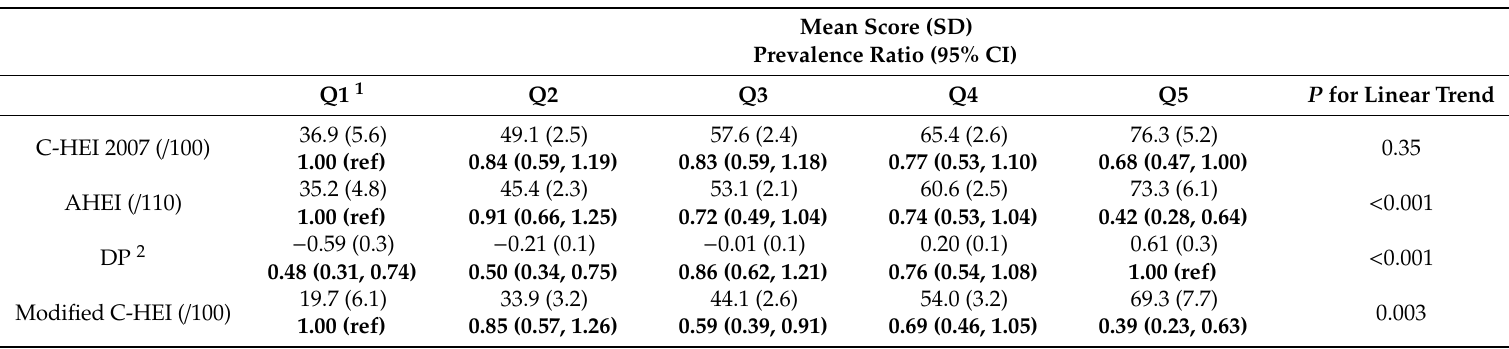
Binomial regression adjusted for age (continuous), physical activity (continuous), energy (continuous), smoking status (2 categories), sex (2 categories), ethnicity (2 categories), marital status (2 categories), and education (3 categories). Note: P for linear trend across the prevalence ratio for all quintiles. 1 Reference is the 5th quintile (strongest adherence and lowest diet quality) for DP and the first quintile (lowest adherence and lowest diet quality) for C-HEI 2007, AHEI, and Modified C-HEI. 2 Scores for the DP were generated by summing the product of standardized food group portion ( z -score) coe ffi cients and individual intakes for all participants. The bold format aim at di ff erentiate Prevalence ratio from mean score which are in the same